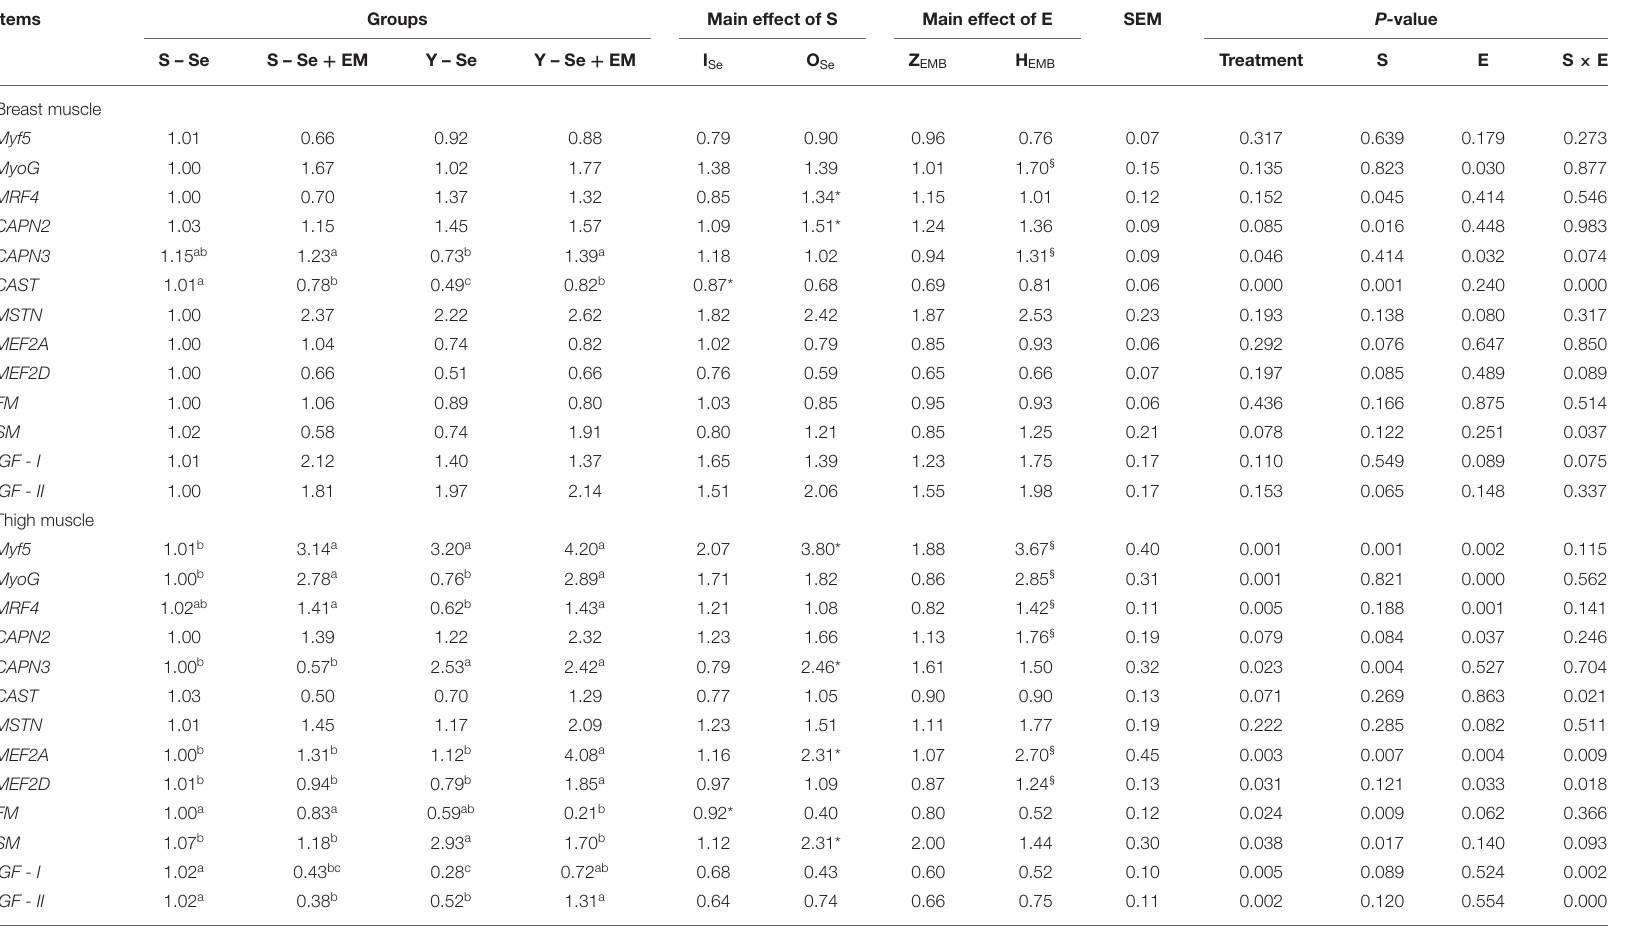
TABLE 7 | Effects of different Se sources and different bacteria levels on the expression levels of muscle fiber-relative genes in the breast and thigh